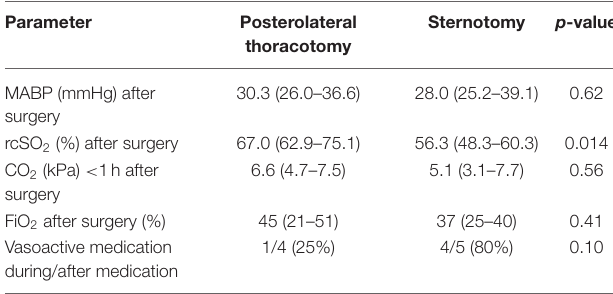
TABLE 2 | Values during and after surgery of the infants that underwent ductal ligation via posterolateral thoracotomy or via sternotomy.